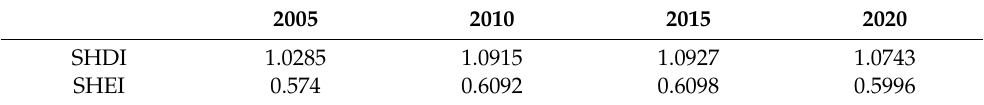
Table 3. Changes in the landscape-level metrics in Harbin between